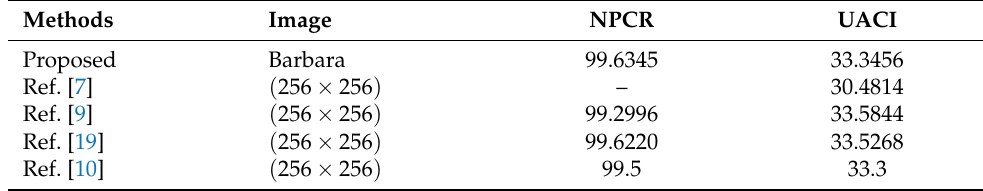
Table 6. Comparison of NPCR and UACI results.